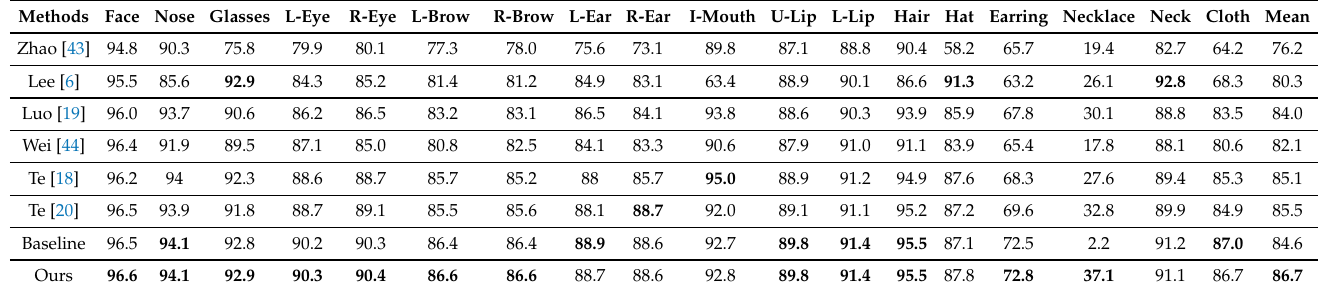
Table 3. Performance comparison between our approach and state-of-the-art methods on the CelebAMask-HQ test set in terms of F1 score. Bold font indicates the best results in different categories.